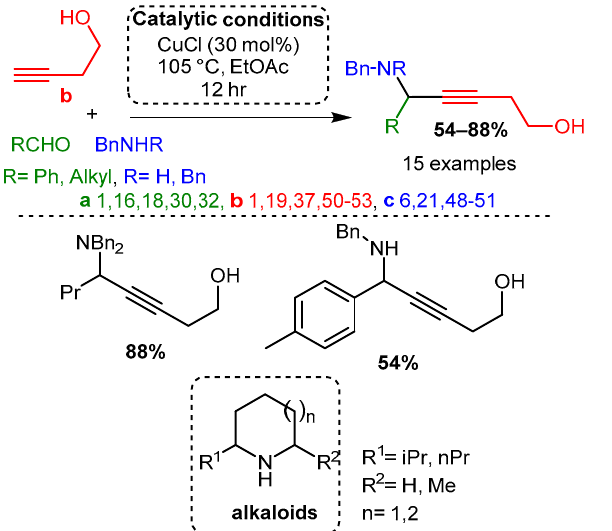
Scheme 9. Formation of monocyclic oxazolidines from chiral amino alcohols.